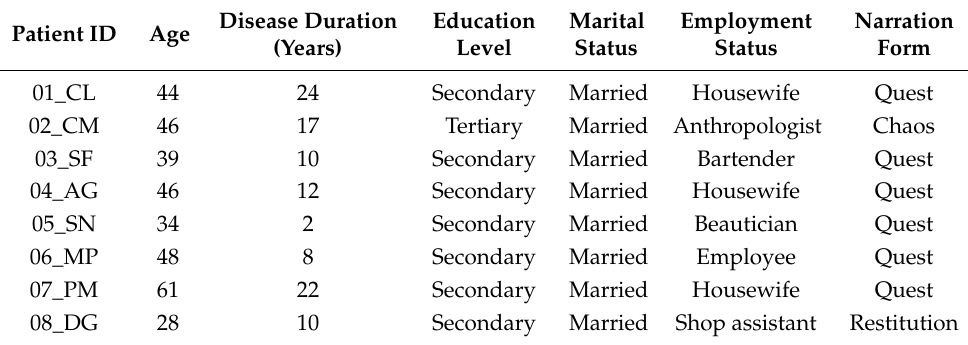
Table 1. Socio-demographic information and type of narration for each